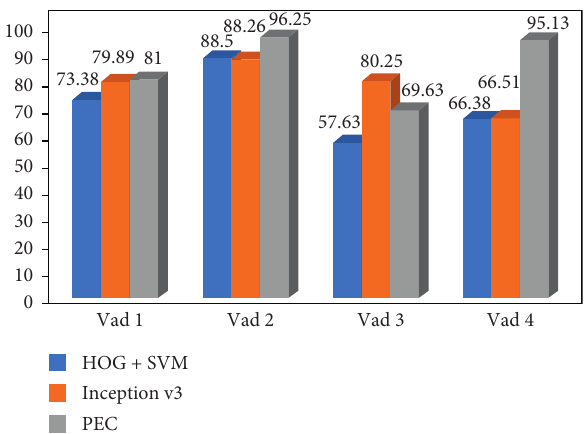
Figure 12: Comparison of the four validation performances be- tween HOG +SVM, Inception v3, and PEC: Vad 1: train and test with PSU data samples, Vad 2: train and test with INRIA data samples, Vad 3: train with PSU data samples and test with INRIA data samples, and Vad 4: train with INRIA data samples and test with PSU data